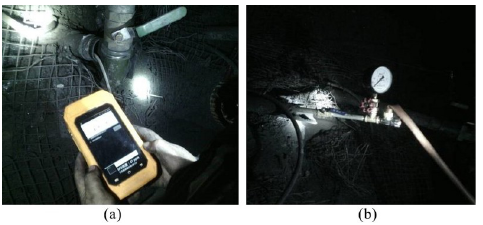
Fig 13. In situ determination of tracer gas SF 6 . (a) Gas concentration recorder. (b) Pressure